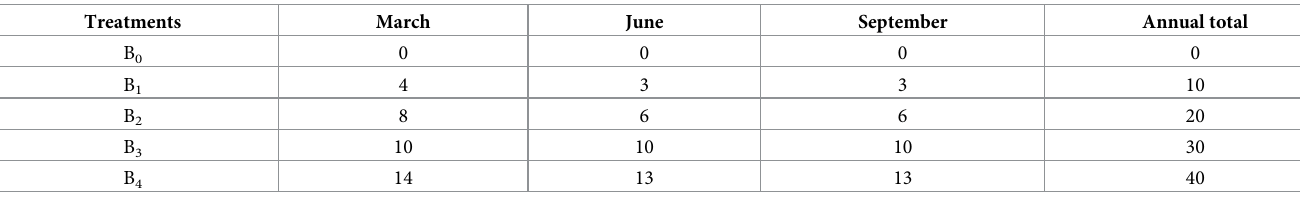
Table 1. Experiment design (Unit: